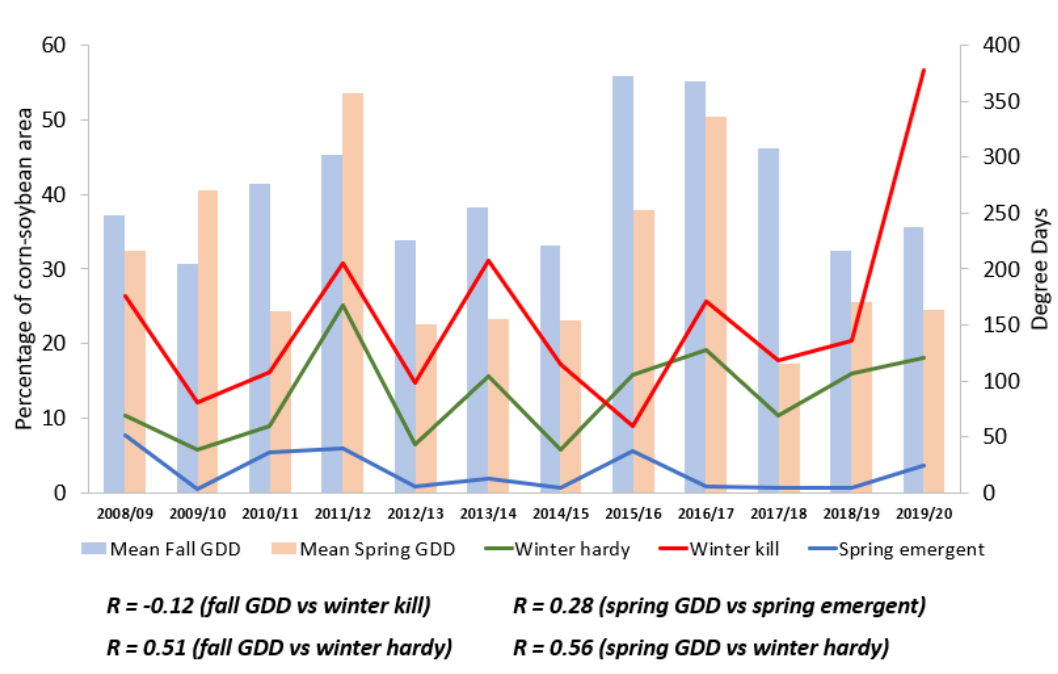
Figure 7. Relationship between cover crops and GDD. Note: years in x-axis indicates fall of a prior year and spring of following year, left Y-axis indicates cover crop areas expressed in terms of % of corn/soybean areas, and right Y-axis indicates GDD.